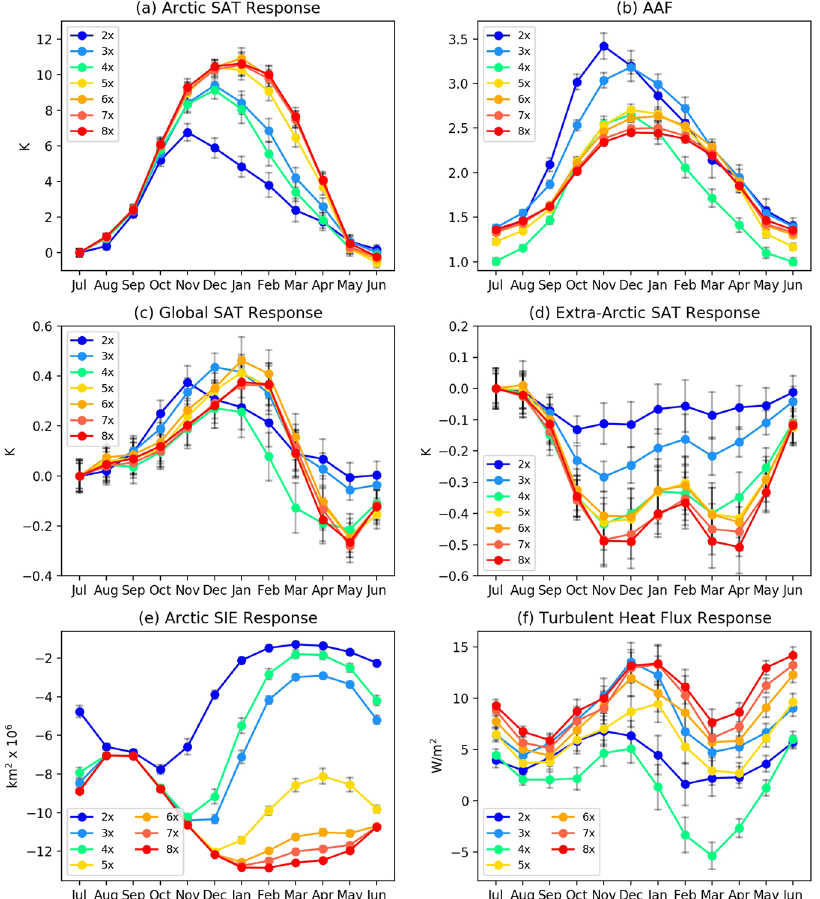
Fig. 4 Seasonal evolutions of the Arctic SAT, SIE, turbulent heat fl ux response, and AAFs in the abrupt CO 2 forcing experiments. a The evolution of Arctic SAT responses for 2× to 8 × CO 2 . b Similar as ( a ) but for AAF. c , d Same as ( a ) but for global and extra-Arctic (90°S – 59°N) SAT responses. e , f Same as ( a ) but for SIE and turbulent heat fl ux responses. Error bars denote 95% con fi dence intervals calculated using Student ’ s t -distribution. Values in a , c and d are referenced to July values. All quantities are computed from the fully-coupled model